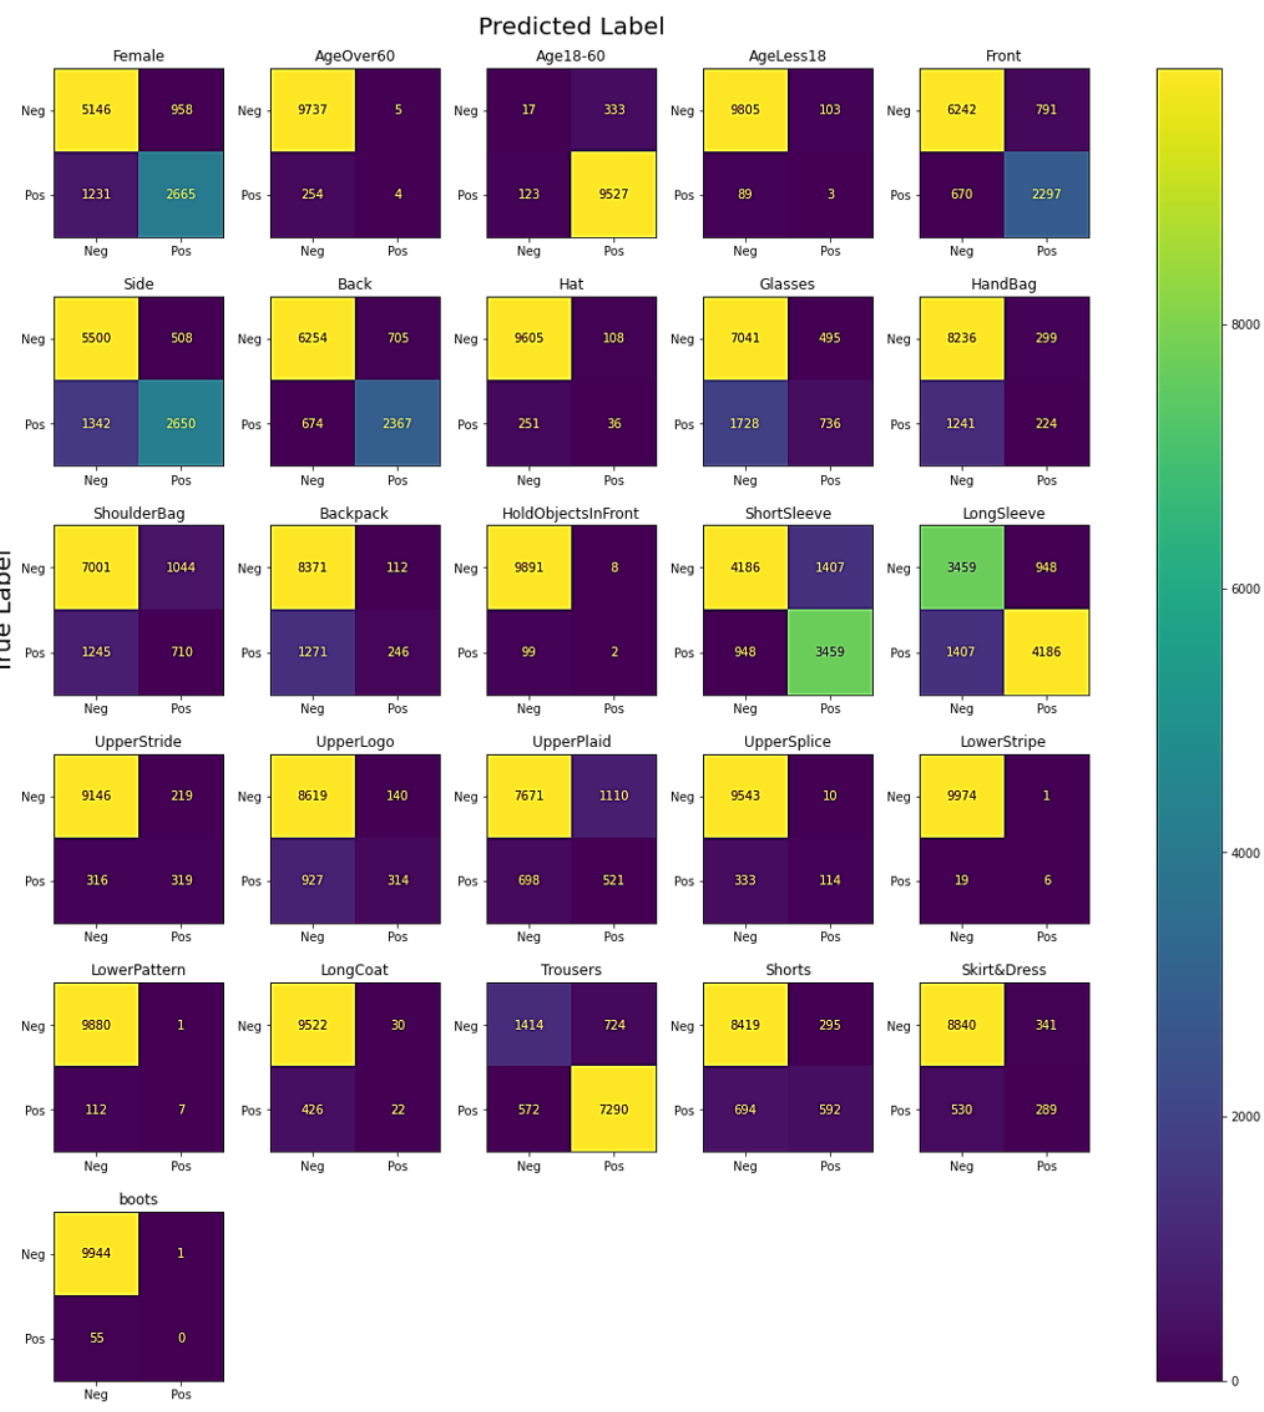
Figure 17. Confusion matrix of Model 5 on the PARSE100K